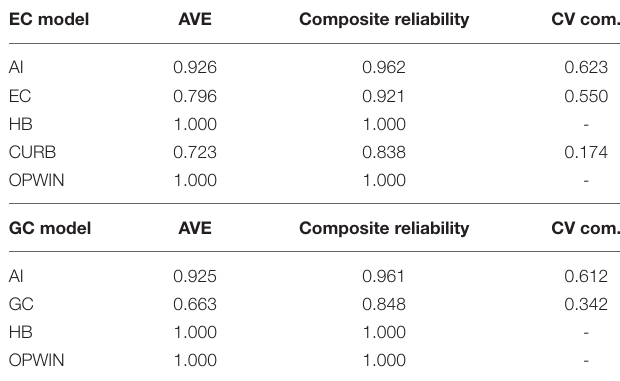
TABLE 6 | Factor loading and T statics of measurement model. TABLE 7 | Reliability validity and quality of the measurement model.